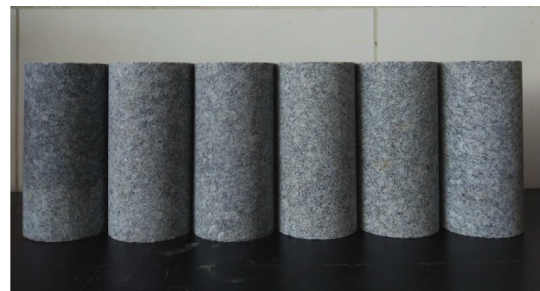
Figure 3: The granite samples and its optical image.